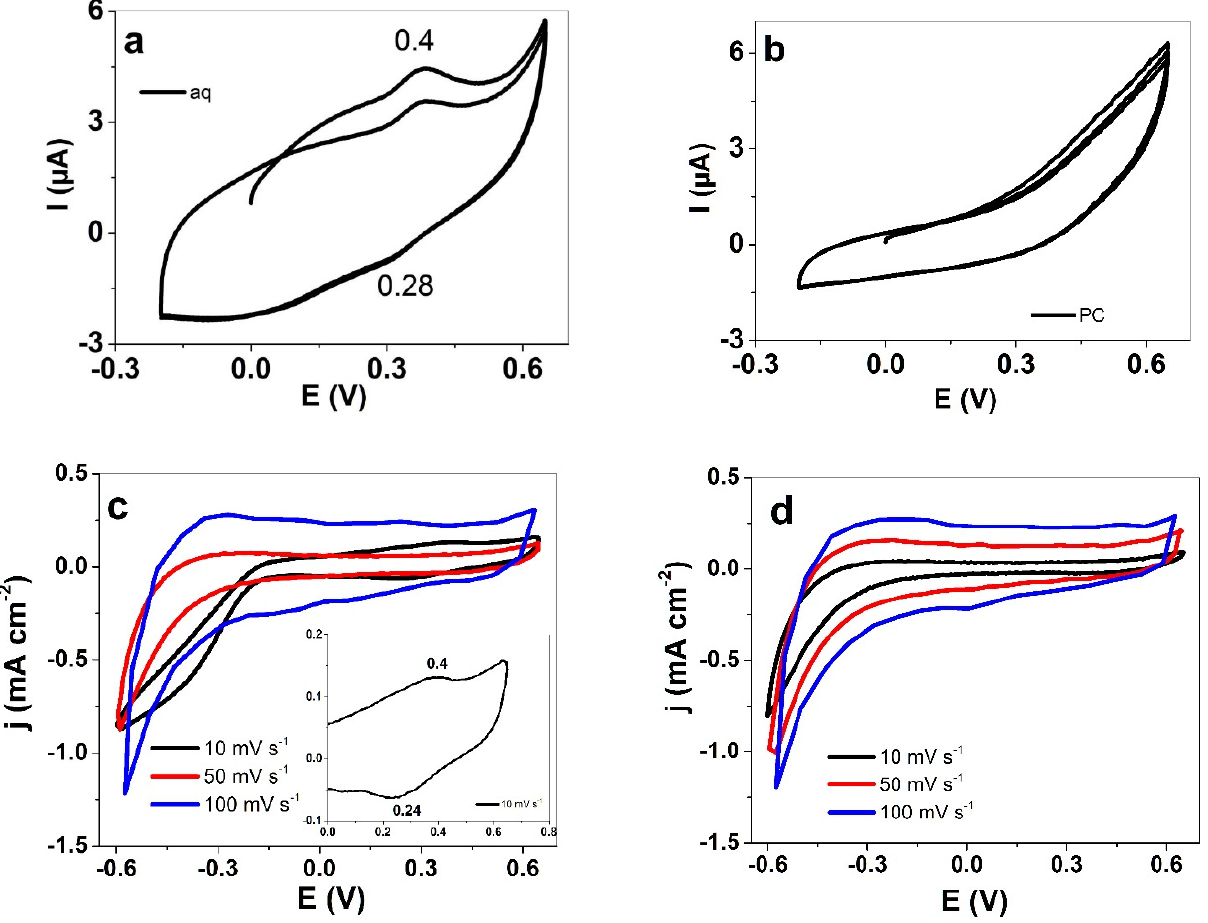
Figure 3. Modified SICM methodology during cyclic voltammetric measurements (scan rate 50 mV s − 1 ) of surface of PIL samples at a potential range 0.65 V to − 0.2 V using ( a ) LiTFSI-aq (aq) and ( b ) LiTFSI-PC (PC) as electrolytes. Cyclic voltammetry (3rd to 4th cycle) of PIL films at different scan rates 10 mV s − 1 (black line), 50 mV s − 1 (red line) and 100 mV s − 1 (blue line) are depicted as current density j curves against potential E using ( c ) LiTFSI-aq (aq) (the inset depicts the curve at 10 mV s -1 scan rate at potential section from 0.65 V to 0.0 V) and ( d ) LiTFSI-PC (PC) as electrolytes.